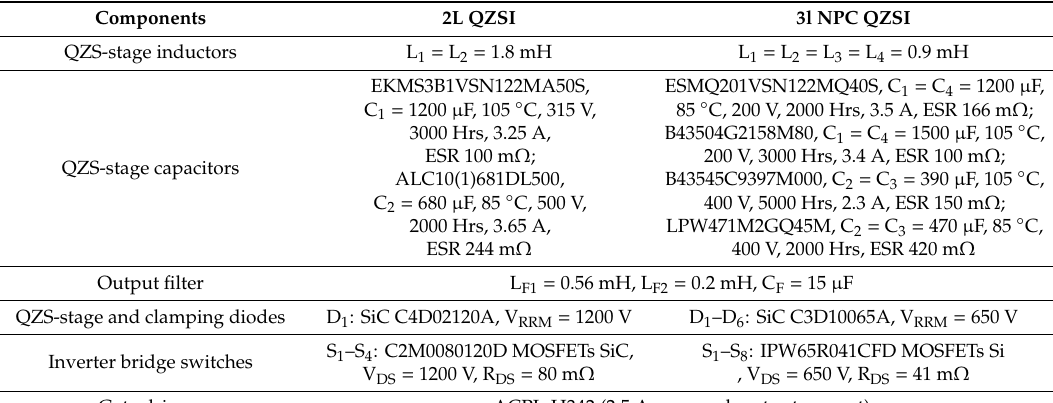
Table 3. Selected